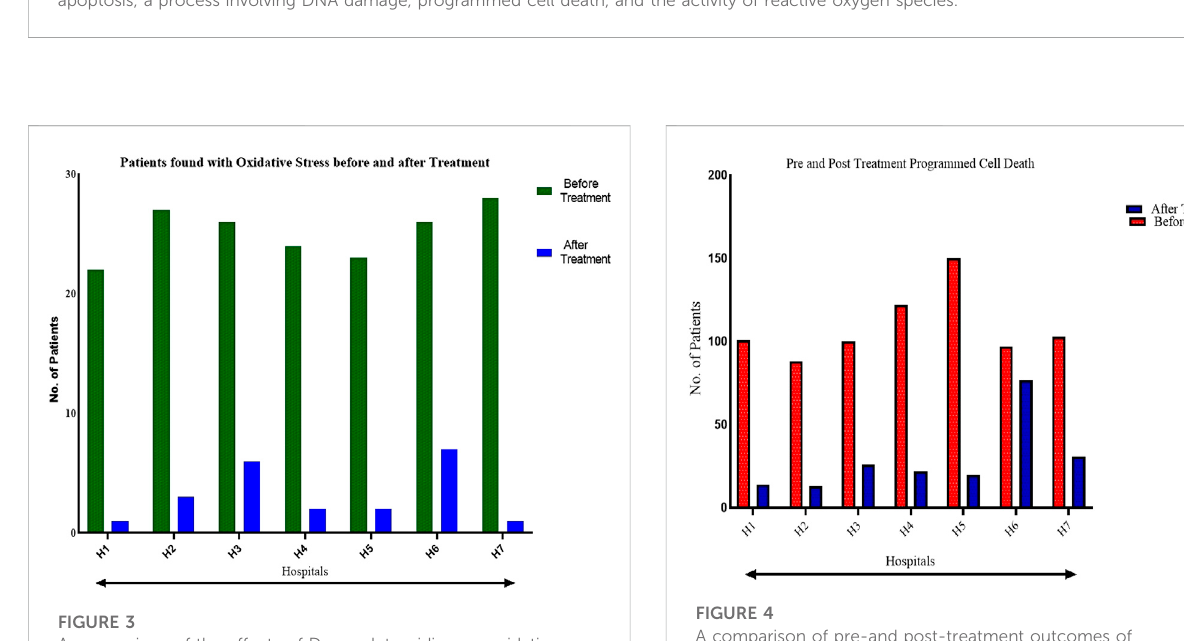
FIGURE 2 A schematic representation of oxidative stress and the resulting mitochondrial damage due to the reactive oxygen species. The cell dies through apoptosis, a process involving DNA damage, programmed cell death, and the activity of reactive oxygen species.